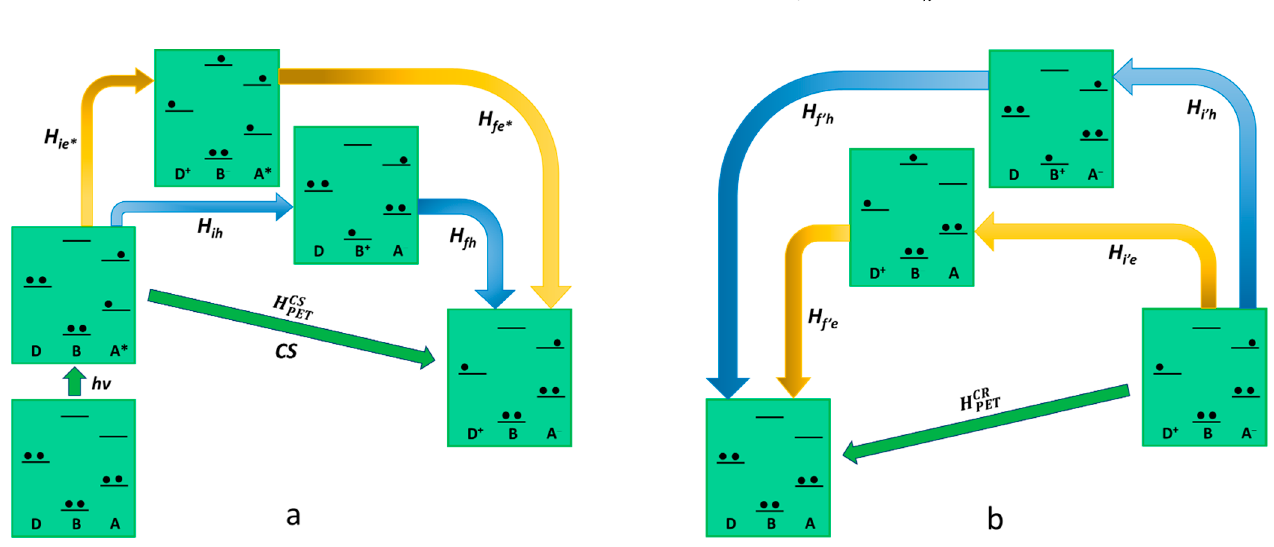
Figure 3. Schematic representation of reductive photoinduced electron transfer in D-B-A dyads, according to superexchange. The states involved in the mechanism (virtual states pathways are described with blue and yellow arrows) are represented in terms of electronic configurations. On the left ( a ) charge separation is described while charge recombination is shown on the right ( b ).